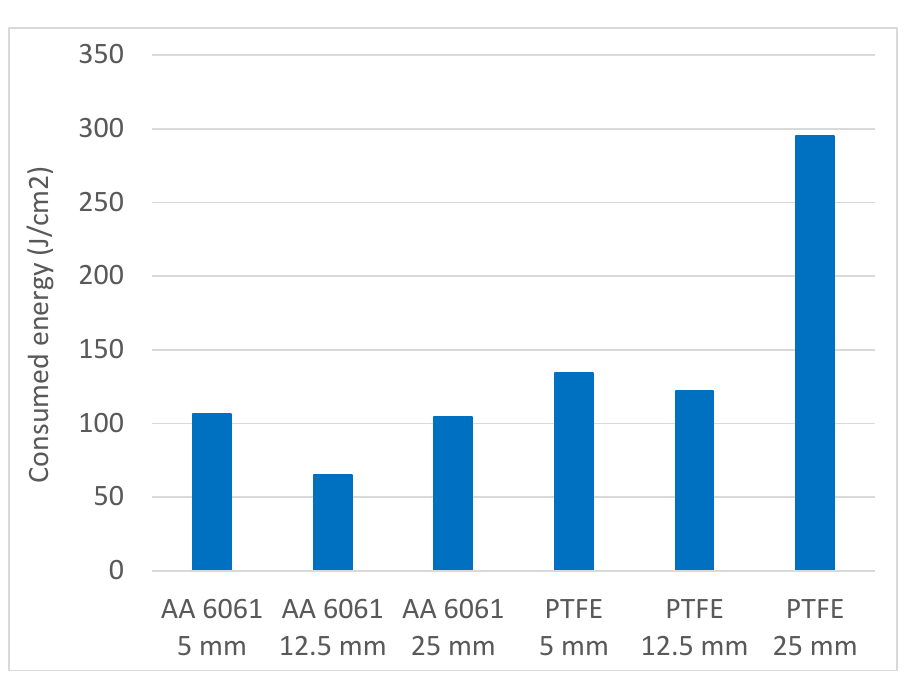
Figure 18. Energy consumption per protected area.